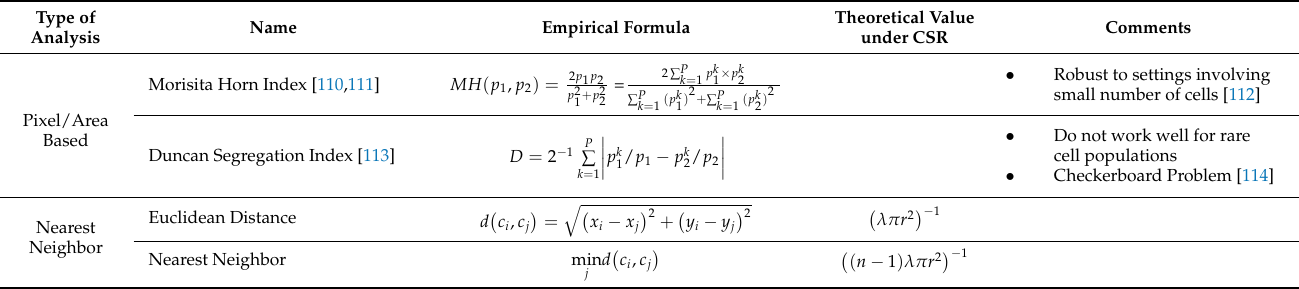
Table 1. Summary of the spatial measures outlined in Section 4 with the distinction for the spatial point processes being made to highlight the duality between distance to the nearest neighbor and locations of